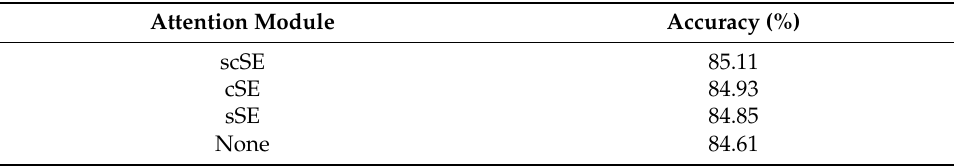
Table 8. Effects of different attention modules.